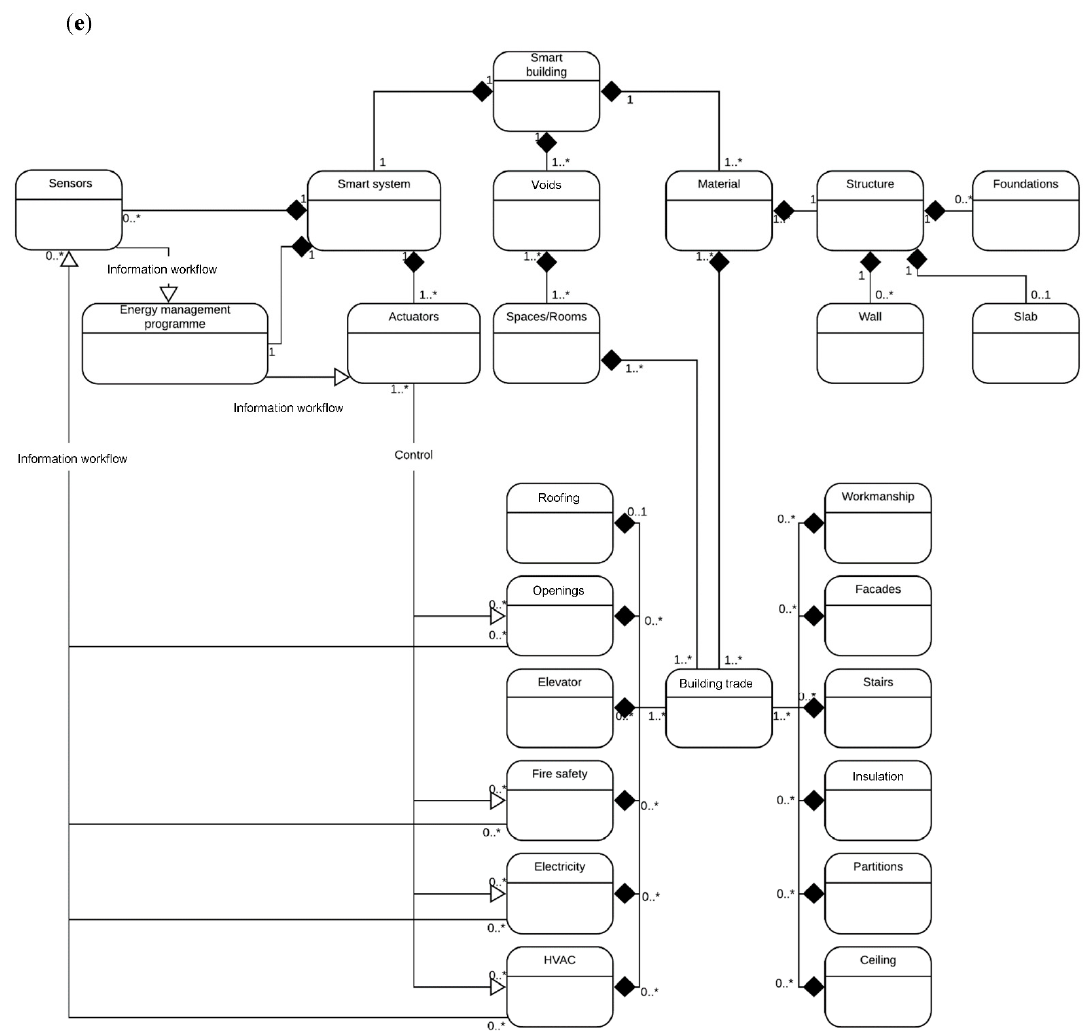
Figure 3. A conceptual model of a smart building system using SysML. ( a ) Requirement diagram. ( b ) Block definition diagram. ( c ) Sequence diagram. ( d ) Use case diagram. ( e ) Internal block diagram. (*. A SysML notation that means ‘many’.) •